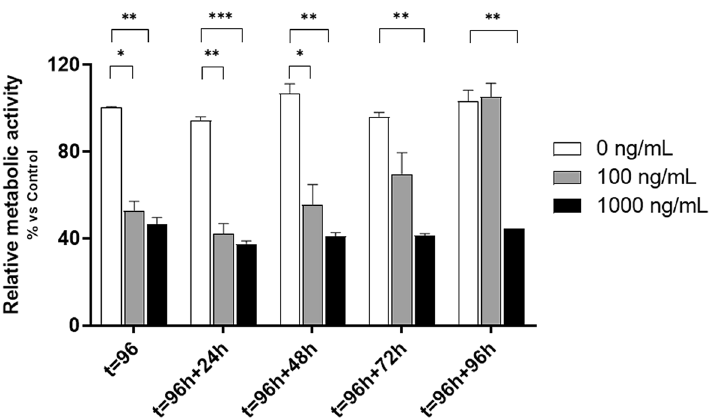
Figure 2. Relative metabolic activity after media refreshment. After 96 h of incubation, medium containing MTX was washed away and fresh media was added. Supernatant was collected at 24, 48, 72 and 96 h and WST-1 performed (n = 3). All data are presented as mean ± SEM. * ( p < 0.05), ** ( p < 0.01) and *** ( p < 0.001) represent the significant changes between MTX-treated and untreated